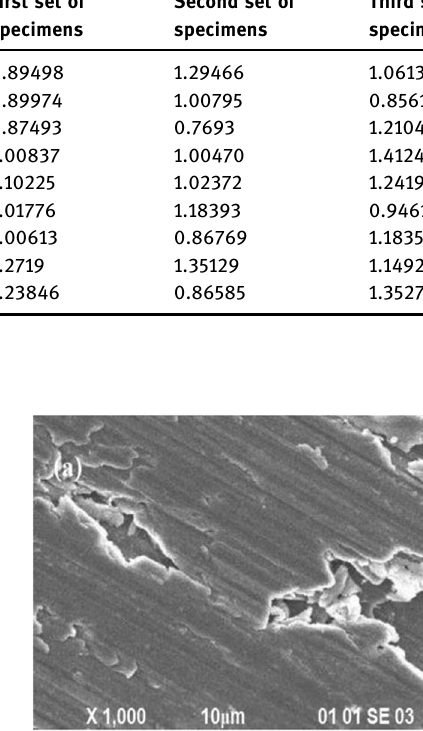
Figure 4: Wear morphology of samples ( a ) FSW 1 and ( b ) FSW 9